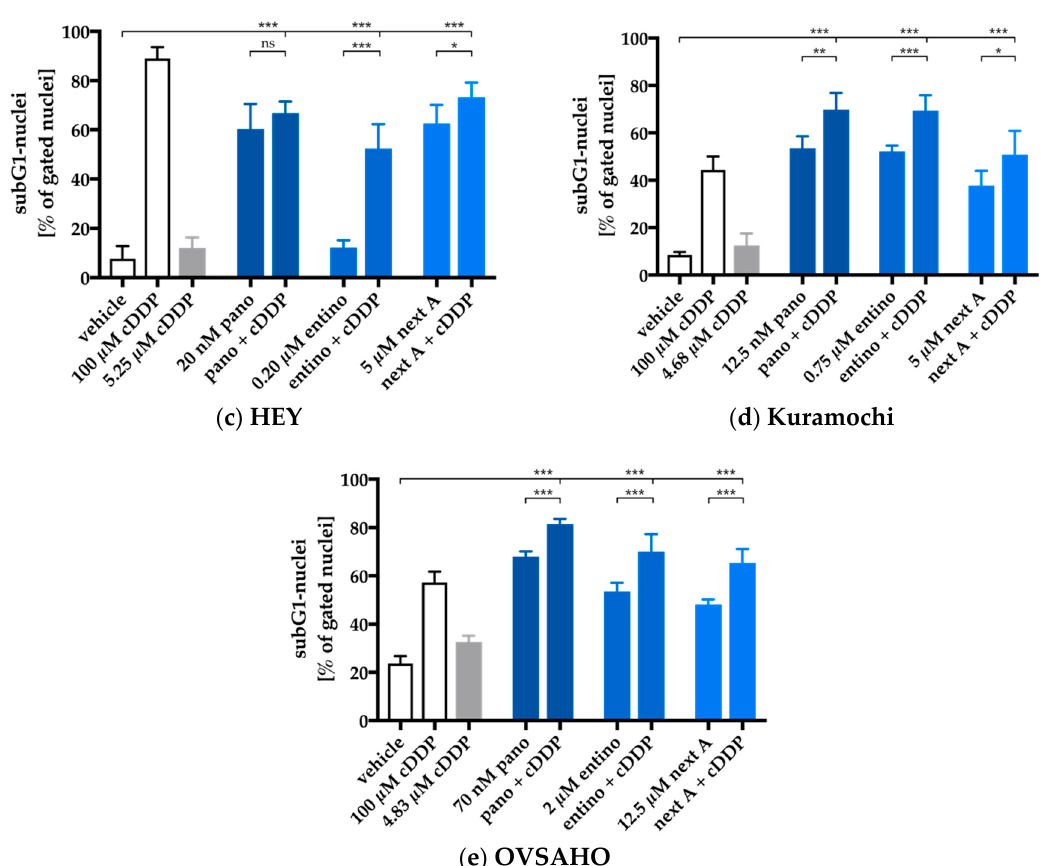
Figure 4. HDACi pretreatment enhances cisplatin-induced apoptosis. A2780 ( a ), CaOV3 ( b ), HEY ( c ), Kuramochi ( d ), and OVSAHO ( e ) cells were preincubated with HDACi for 48 h. Cisplatin was added in an IC 50 concentration for each cell line for a further incubation period of 24 h. Apoptosis was analyzed by determining the sub-G1 cell fractions by flow cytometry analysis. 100 µM cisplatin served as positive control for apoptosis induction. 0.2% DMSO was added as a control for vehicle treated cells. All experimental conditions were incubated for same time periods. Data are the mean ± SD, n ≥ 2. Statistical analysis to compare the apoptosis induction by cisplatin or HDACi alone and the combination of HDACi and cisplatin was performed using t -test. Levels of significance: ns ( p > 0.05); * ( p ≤ 0.05); ** ( p ≤ 0.01); *** ( p ≤ 0.001).